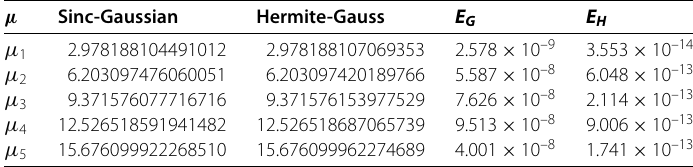
Table 2 Comparison of Hermite-Gauss and sinc-Gaussian, N = 7 and h = 1 μ Sinc-Gaussian Hermite-Gauss E G E H μ 1